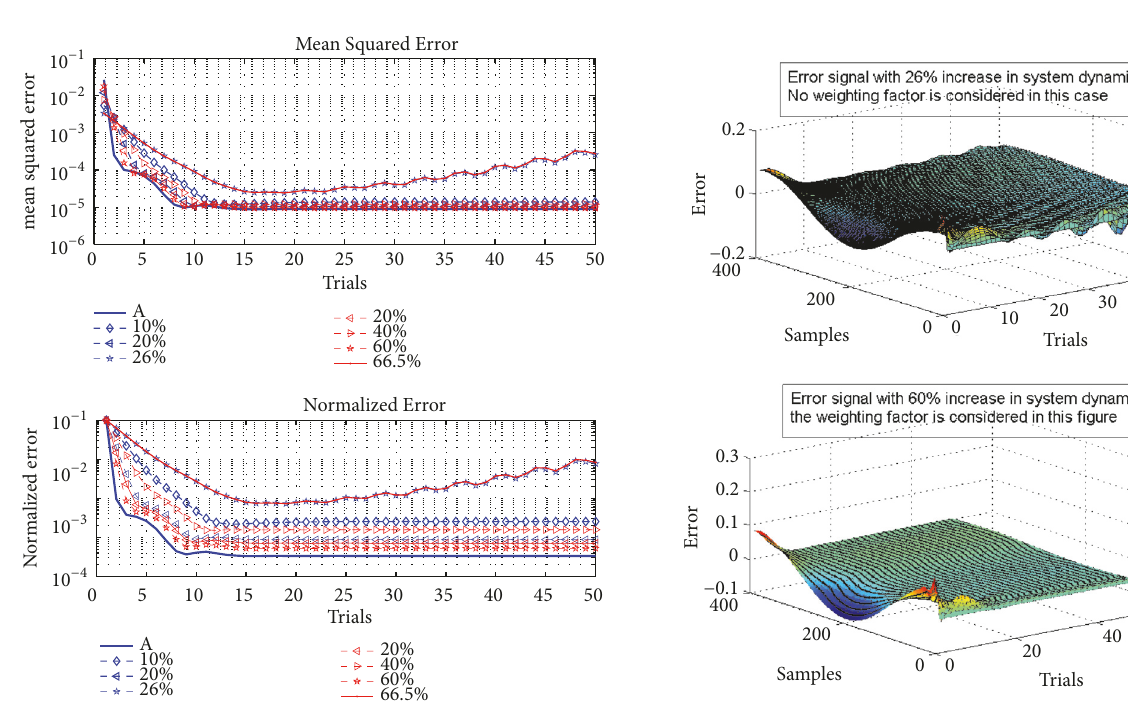
Figure 4: 𝑥 -axis mean squared error for the two different cases, with and without 𝑤.𝑓.